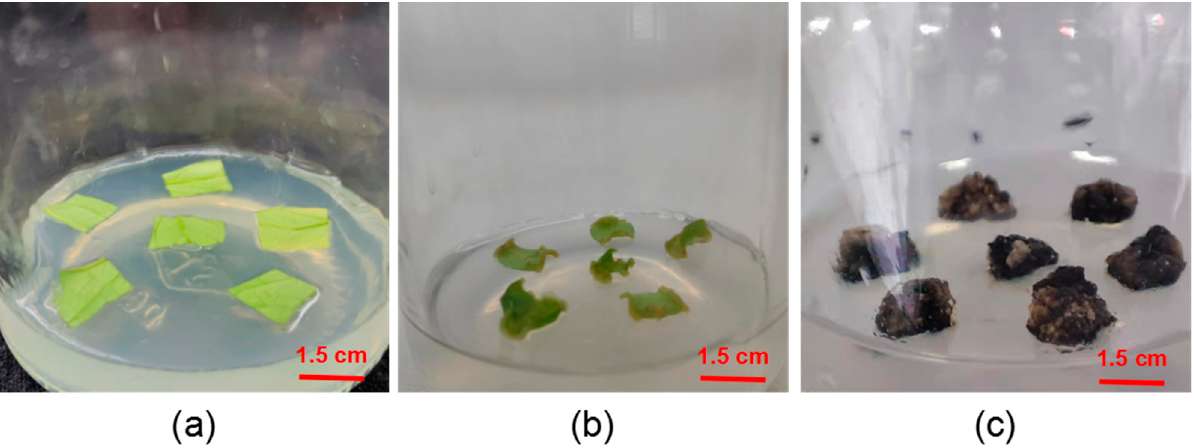
Figure 2. Process of leaves inducing calli. ( a ) Leaf discs connected to the culture medium after 5 days. ( b ) Callus leaf discs curled up after 10 days of culture. ( c ) Callus dimensions increase to 1.5 × 1.5 cm 2 after 25